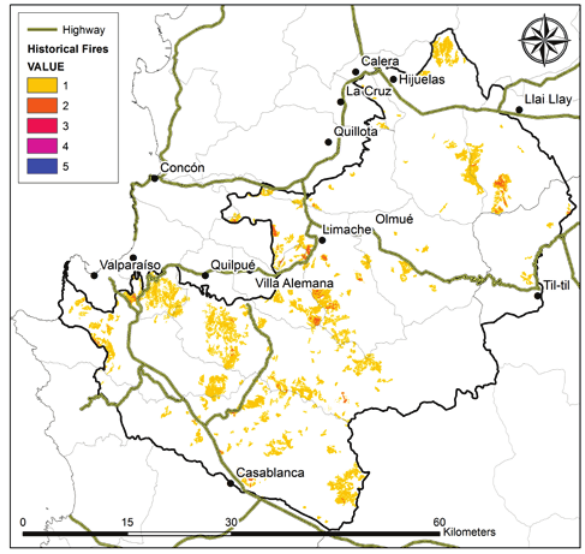
Figure 6. Cumulative fire